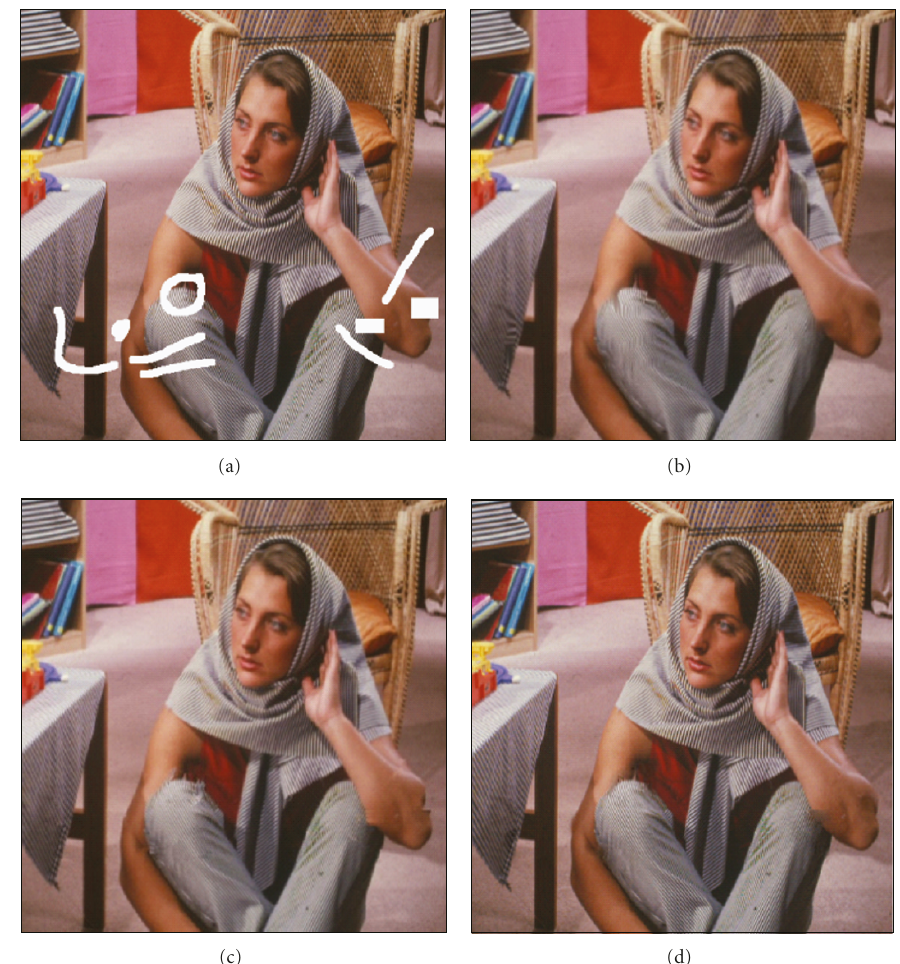
Figure 11: A test image for completing artificially degraded regions (a), the constrained PDE-based-method [3] (b), the modified exemplar- based inpainting method (c), and the proposed method